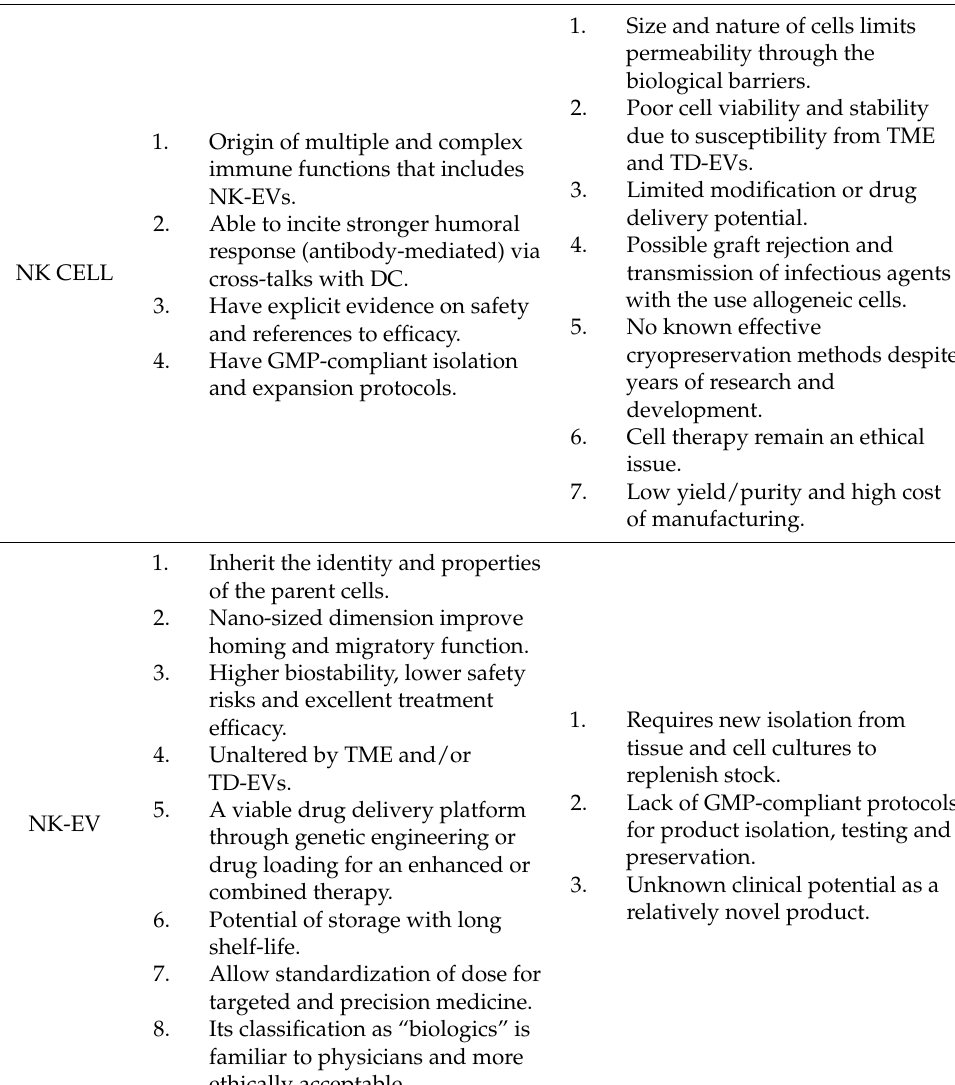
Table 4. Summary of pros and cons of NK cell vs. NK-EV for immunotherapy. Pros